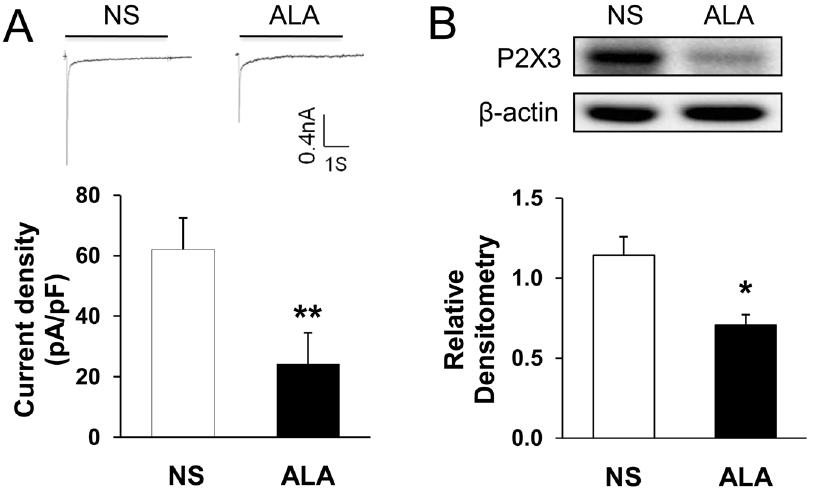
Figure 3. Suppression of ATP current density and P2X3 R expression after ALA treatment in diabetic rats. ( A ) Top: An example of ATP-evoked inward current traces recorded from NS and ALA-treatment rats. Bottom: Bar graph showed a drastical reduction in ATP-evoked current density after ALA treatment (n = 9 cells for each group, ** p < 0.01, compared with NS, two-sample t -test). ( B ) Western blots for P2X3 Rs of T13-L2 DRGs from NS and ALA-treatment rats. Bar graph showed mean density relative to β -actin for P2X3R. ALA treatment greatly reduced expressions of P2X3Rs (n = 4 for each group, ** p < 0.01, compared with NS, two-sample t